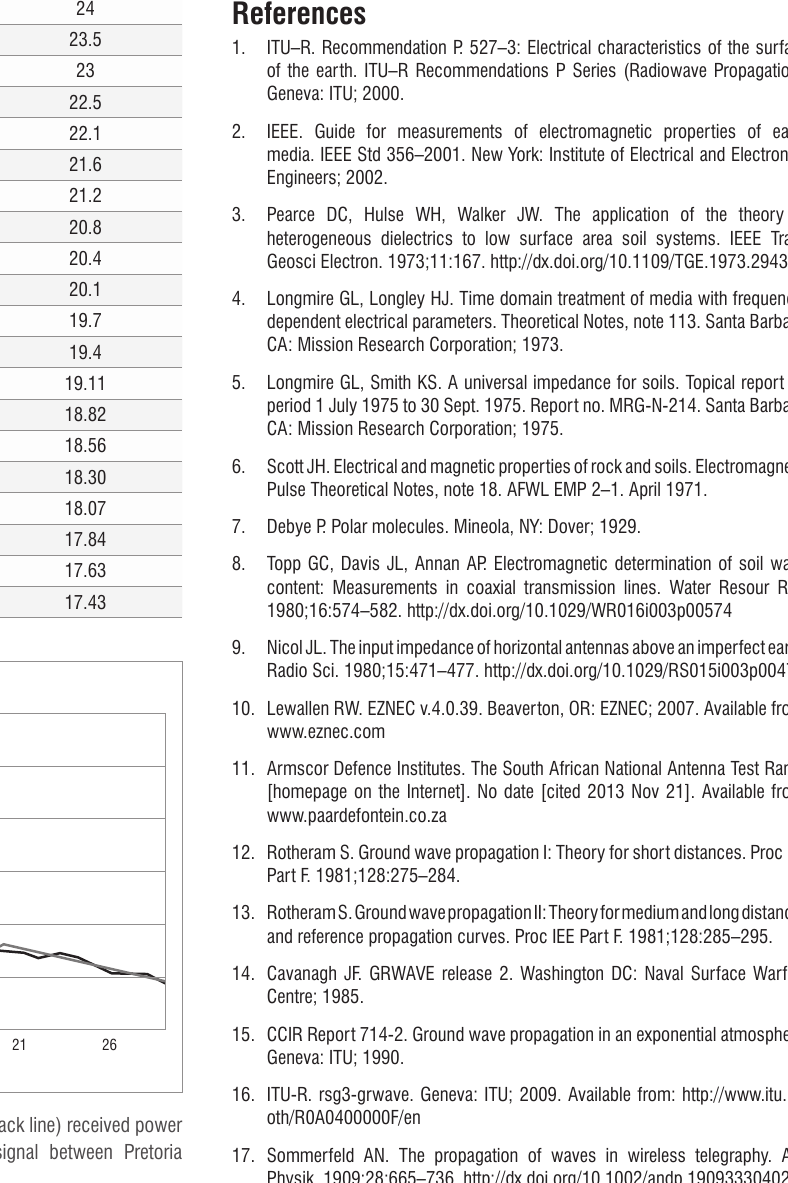
Figure 4: Measured (grey line) and calculated (black line) received power for a high-frequency ground wave signal between Pretoria and